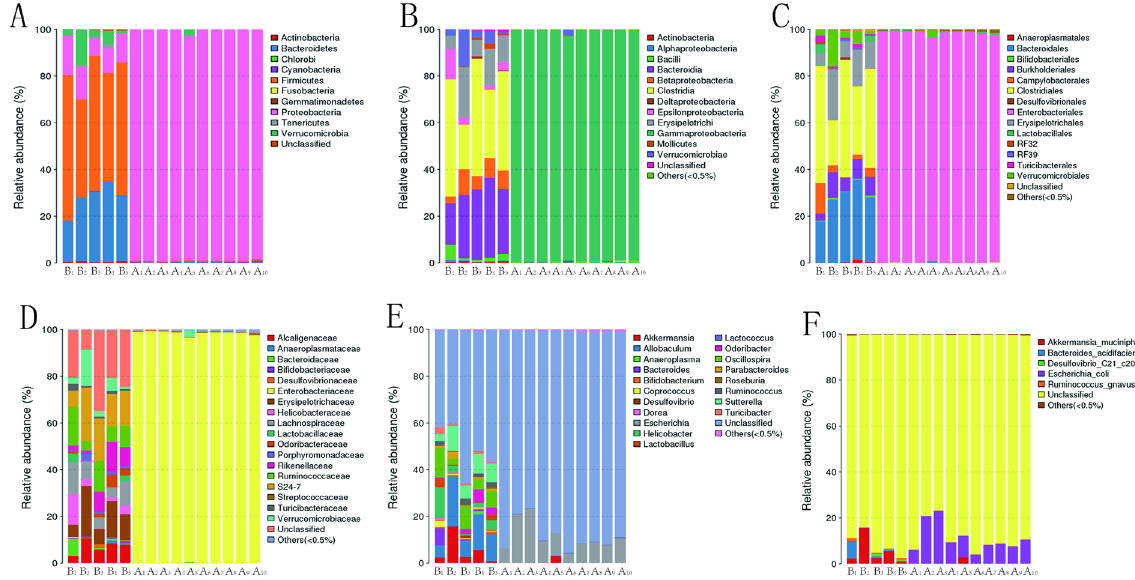
Figure 2. Microbiota composition of antibiotics-treated mice at every level. ( A ) Phylum level; ( B ) Class level; ( C ) Order level; ( D ) Family level; ( E ) Genus level; ( F ) Species level. Group B (n = 5): SPF mice without antibiotics; Group A (n = 10): SPF mice with antibiotics.